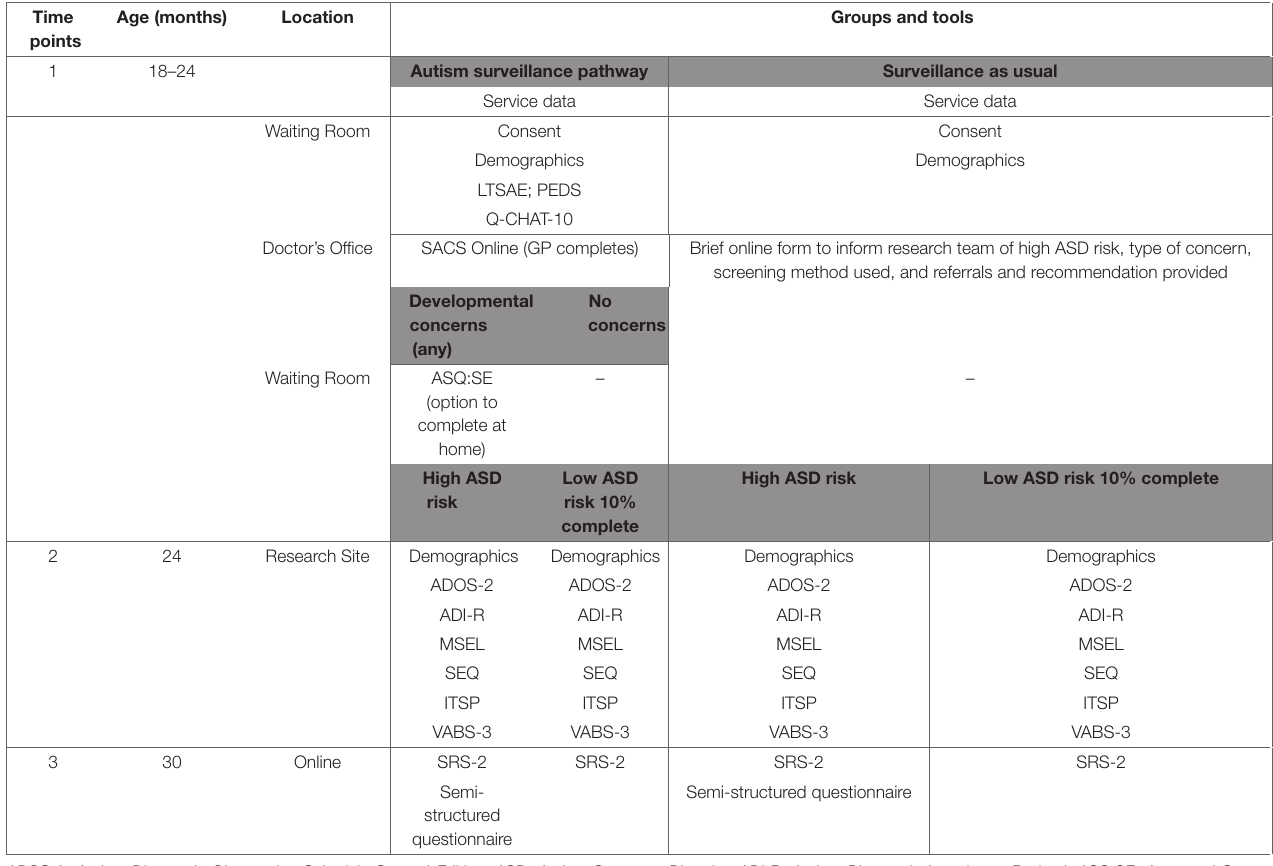
TABLE 1 | Study Flow